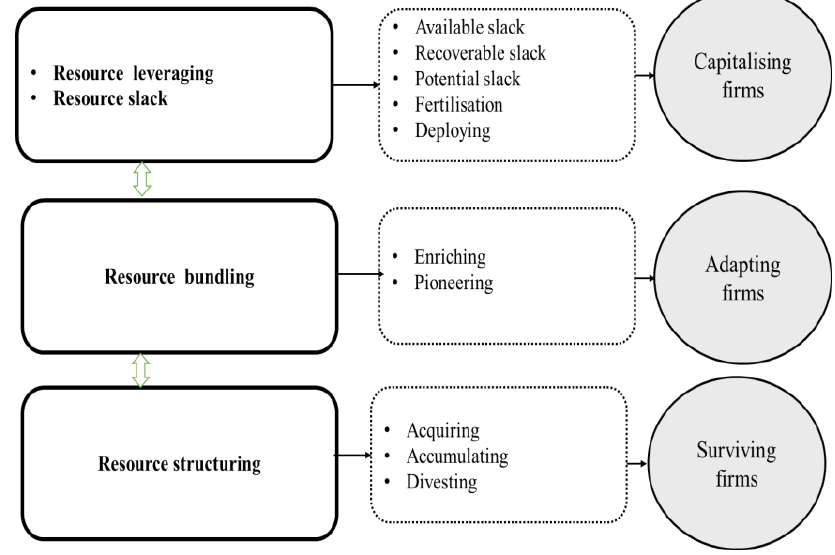
Figure 12: Resource Orchestration Pecking